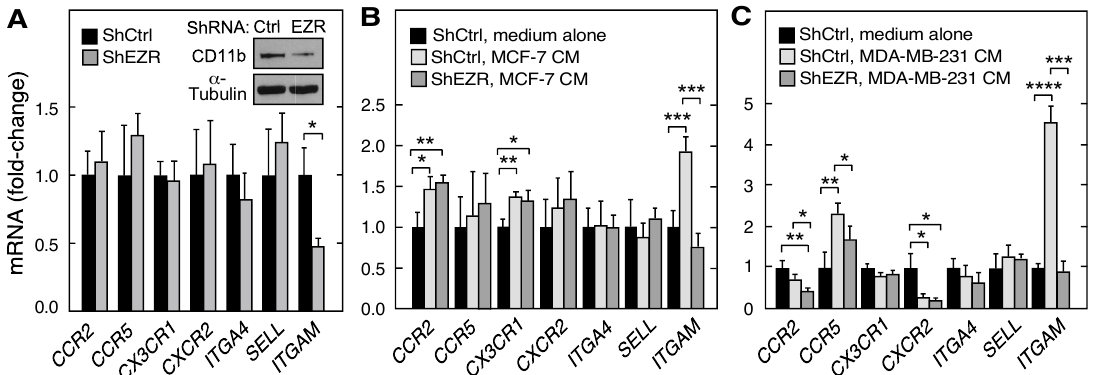
Figure 2. Role of myeloid cell ezrin in the basal and stimulated expression of leukocyte chemokine receptors, integrins, and cell surface adhesion molecules. ( A ) mRNAs encoding leukocyte cell surface proteins in ShEZR THP-1 cells were determined by RT-qPCR and normalized to ShCtrl cell mRNA; (inset) immunoblot analysis of CD11b and α -tubulin. ( B , C ) ShEZR and ShCtrl cells were incubated with CM from MCF-7 ( B ) and MDA-MB-231 ( C ) cells, or with medium alone and mRNAs encoding leukocyte surface proteins determined by RT-qPCR. Mean ± standard deviation; *, **, ***, and **** indicate p < 0.05, 0.01, 0.001, and 0.0001,